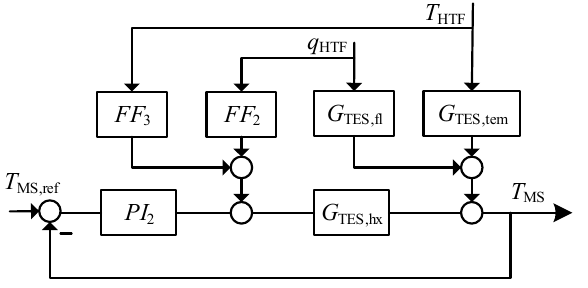
Figure 10. Feedback–feedforward control scheme of the TES subsystem.